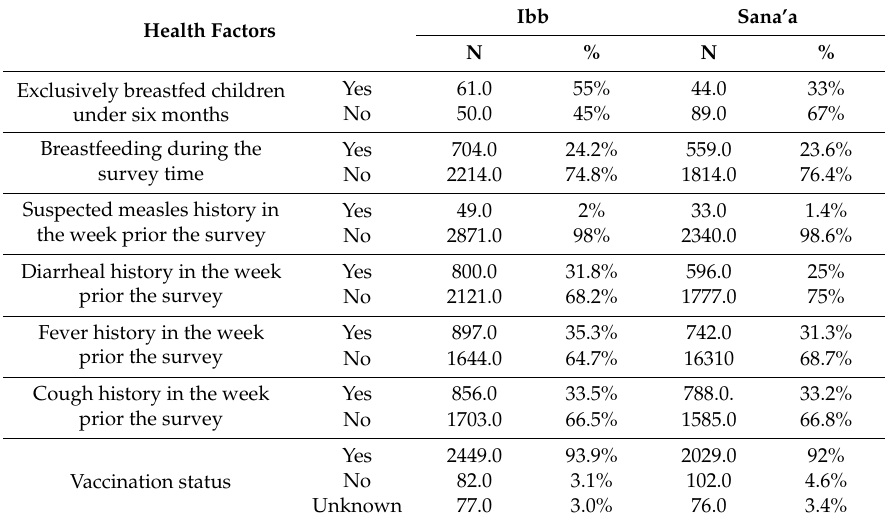
Table 4. Factors a ff ecting the nutritional status of the targeted children under five years of age in Ibb and Sana’a governorates.